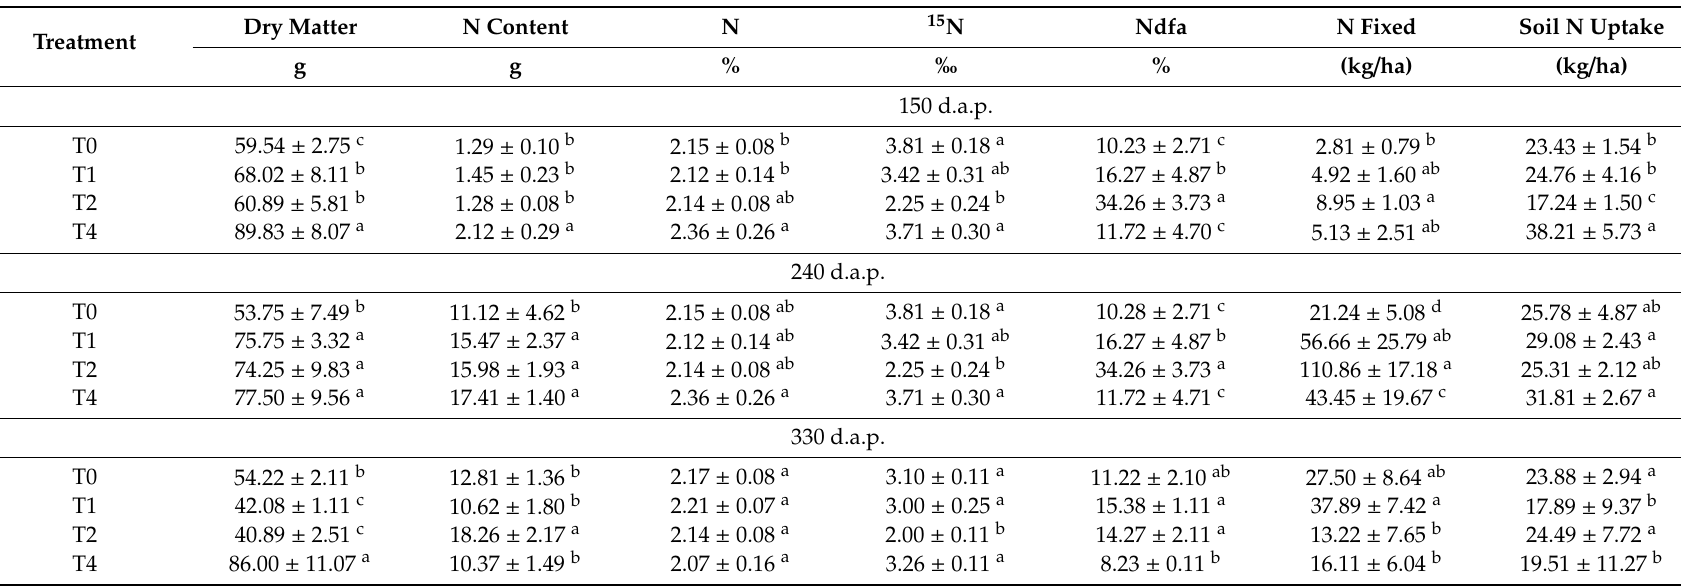
Table 6. Comparison of plant growth, symbiotic performance, and soil N uptake of L. frutescens in response to rhizobium inoculation.